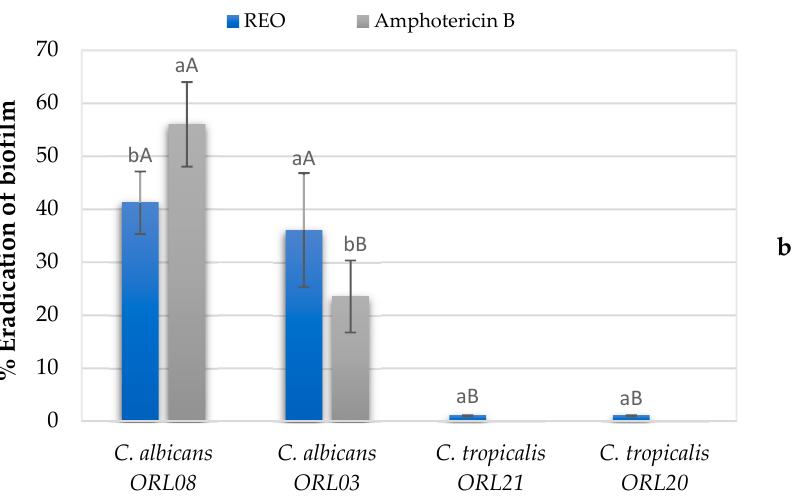
Figure 2. Effect of REO on biofilm of C. tropicalis and C. albicans. Formation of biofilm at 37 °C for 48 h, where OD 590 < 0.1 = nonproducers (NP), OD 590 0.1–1.0 = weak producers (WP), OD 590 1.1–3.0 = moderate producers (MP), and OD 590 > 3.0 = strong producers (SP) ( a ), percentage of eradication of biofilm after 1 h of REO treatment (8.2 µg/mL), amphotericin B (0.5 µg/mL) for C. albicans strains, and amphotericin B (1.0 µg/mL) for C. tropicalis strains ( b ). Results are according to ANOVA test mean values and intervals based on Tukey test for treatments with 95%. Different lowercase letters (a. b. c) indicate significant differences between treatments according to the Tukey test in a confidence interval of 95%. Different uppercase letters (A. B. C) indicate significant differences between strains according to the Tukey test in a confidence interval of 95%.